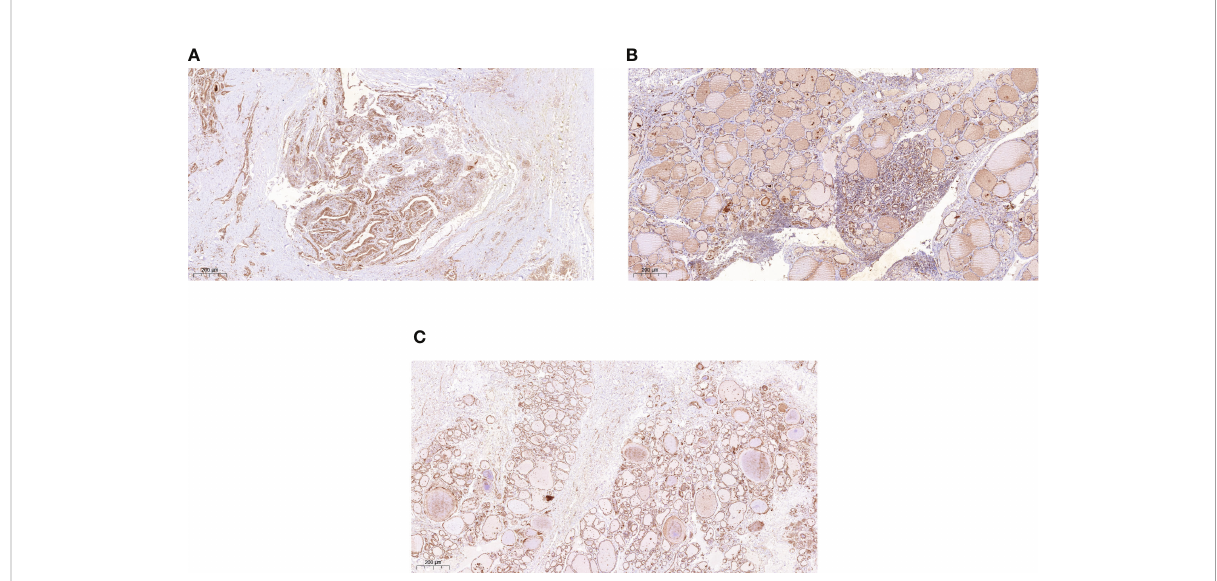
FIGURE 1 The expression of NDRG3 in PTC, paracancerous normal tissues and BTN (200X) (A) Positive expression of NDRG3 in PTC tissues; (B) Positive expression of NDRG3 in normal tissues adjacent to cancer; (C) Positive expression of NDRG3 in BTN tissues. The nucleus and cytoplasm are